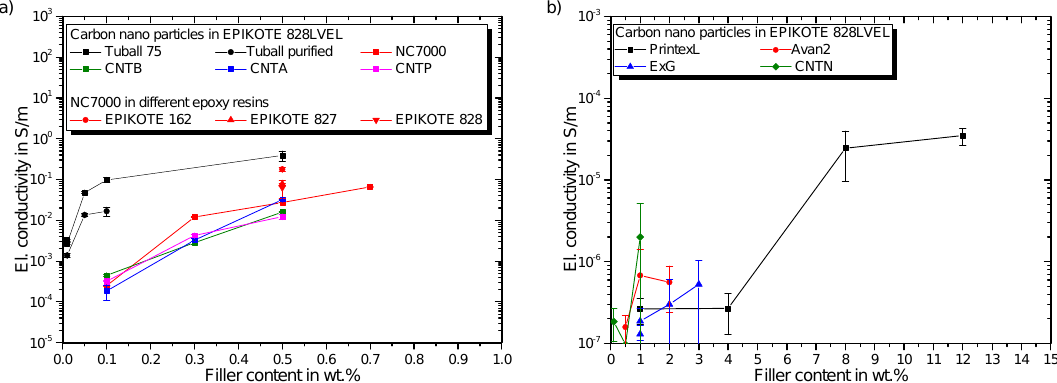
Figure 10. Electrical percolation behavior of ( a ) evaluated MWCNT and SWCNT in epoxy resin ( b ) evaluated planar particles, CB and CNTN in epoxy